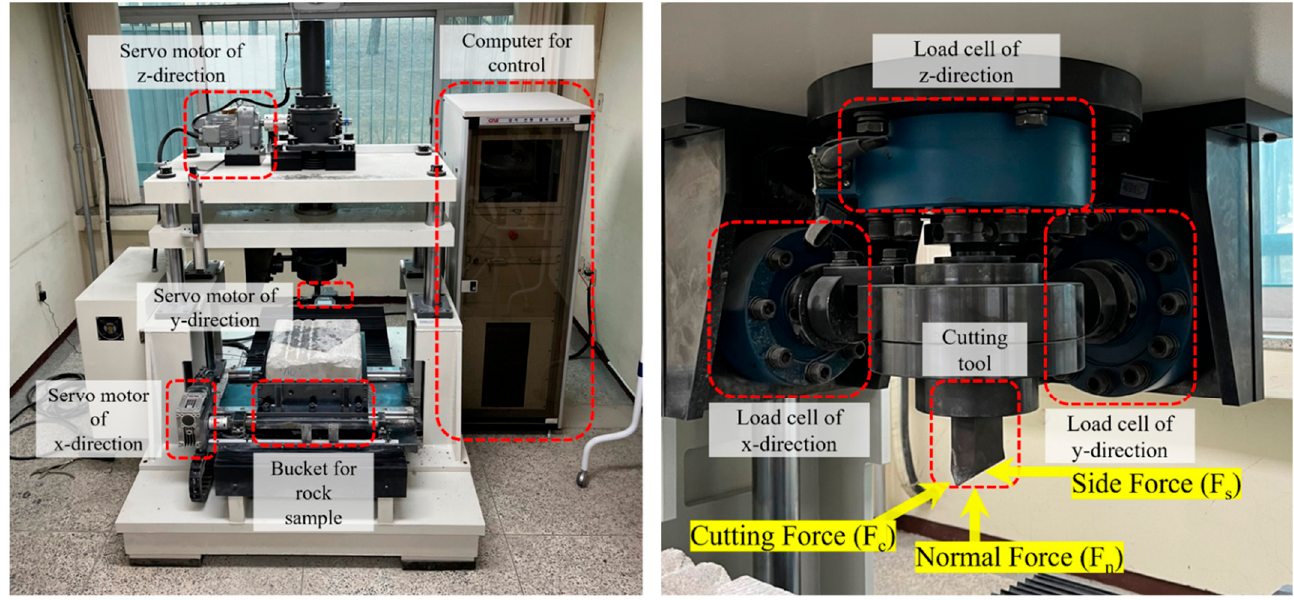
Figure 10. Electrically-driven LCM test bench